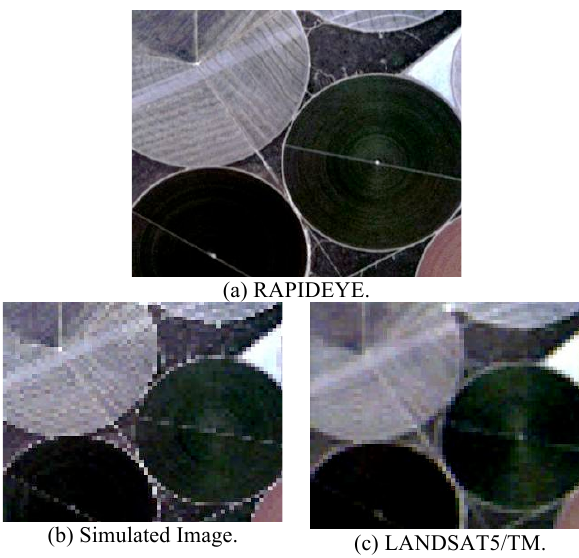
Figure 8. Colored composition (3R2G1B) of (a) RAPIDEYE image, (b) simulated image and (c) real LANDSAT image. The simulated and LANDSAT images present a great visual similarity, as much in color as in spatial details.